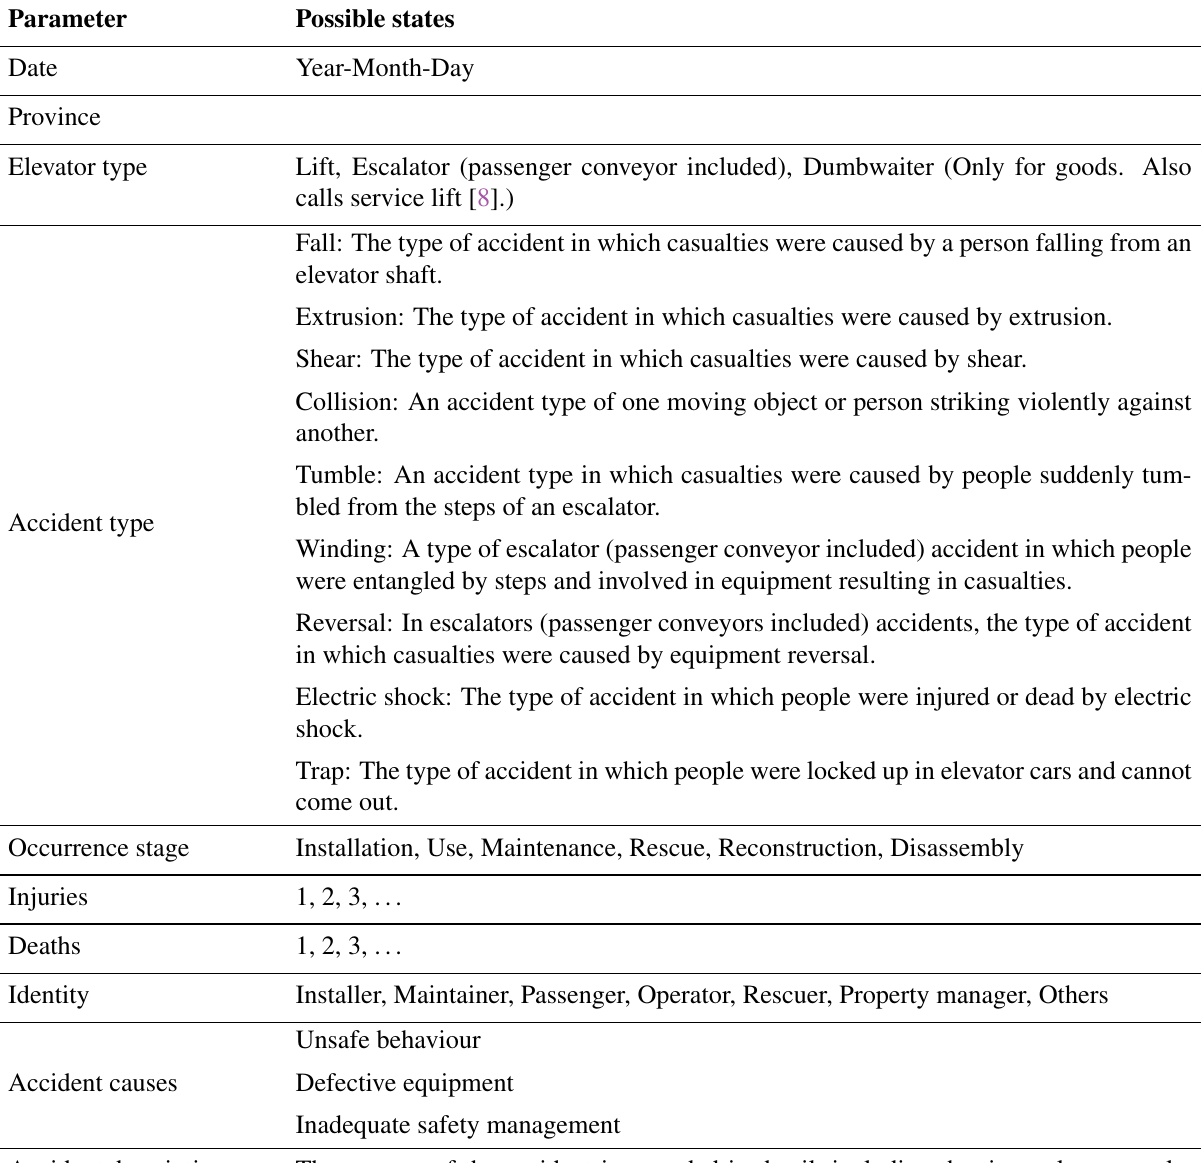
Table 1 Parameters and their possible